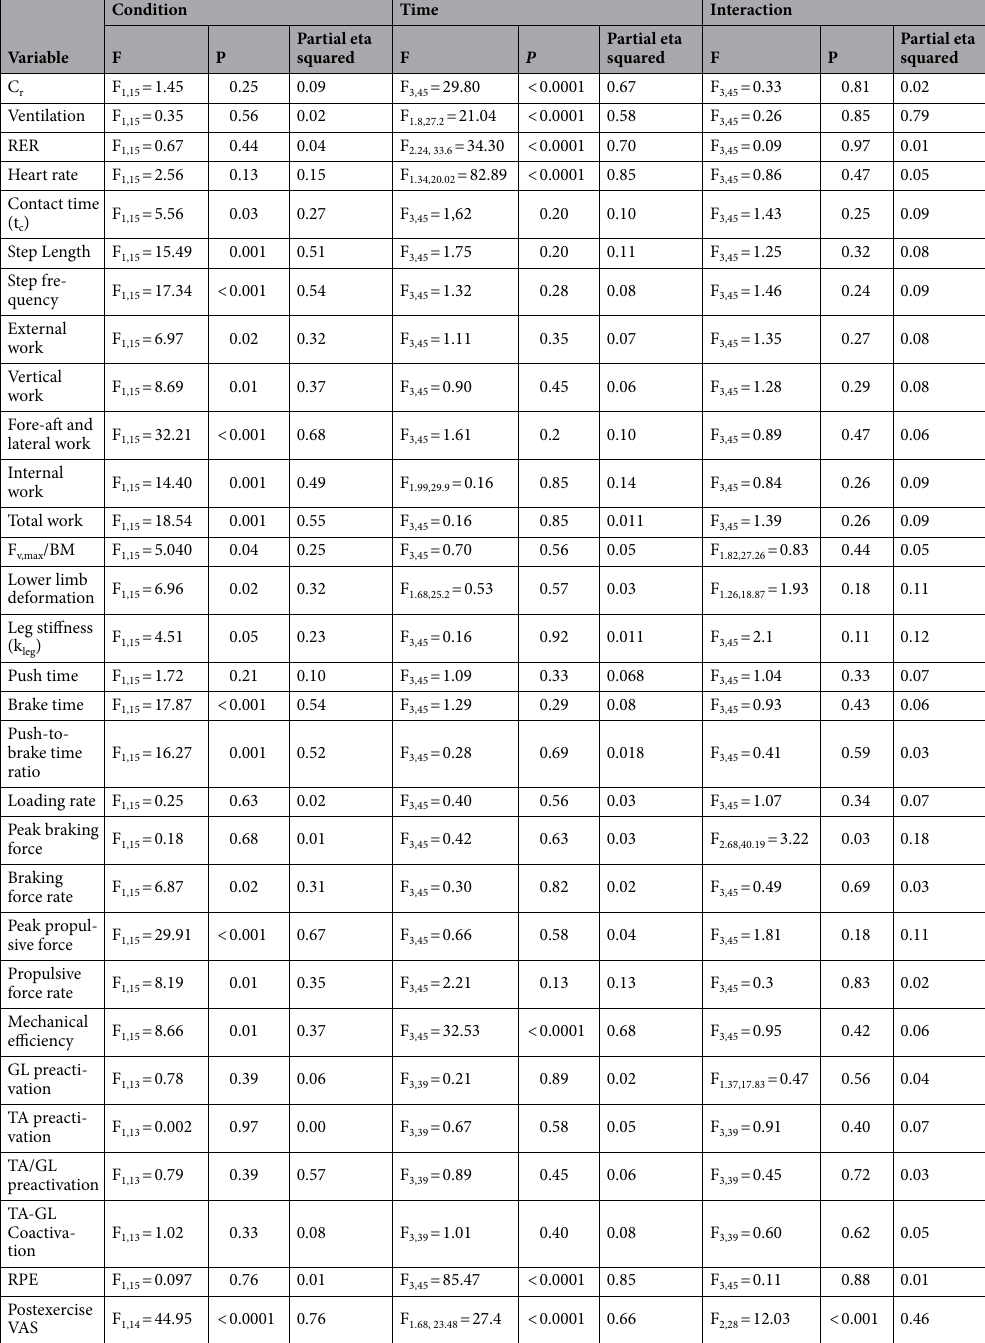
Table 1. F, P and partial eta squared values for the two-way repeated measures ANOVAs [time (5, 15, 30 and 45 min) × shoe condition (MinRS vs, TrdRS)]. MinRS, minimal running shoes; TrdRS, traditional cushioned running shoes; C r , net energy cost of running; RER, respiratory exchange ratio; F v,max , maximal vertical ground reaction force; BM, body mass; TA, tibialis anterior; GL, gastrocnemius lateralis; RPE, rating of perceived effort; VAS, visual analog